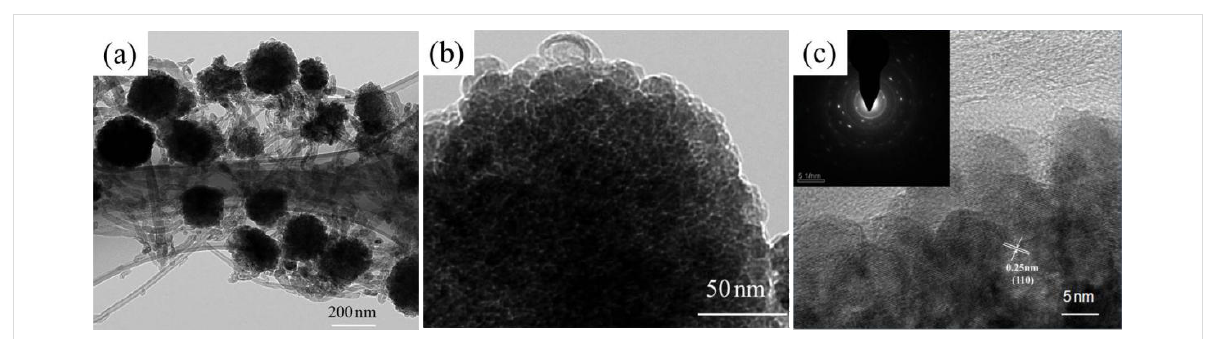
Figure 2: Fe 2 O 3 /COOH-MWCNT composites: (a) and (b) HRTEM; (c) HRTEM and selected area electron diffraction patterns of TEM.